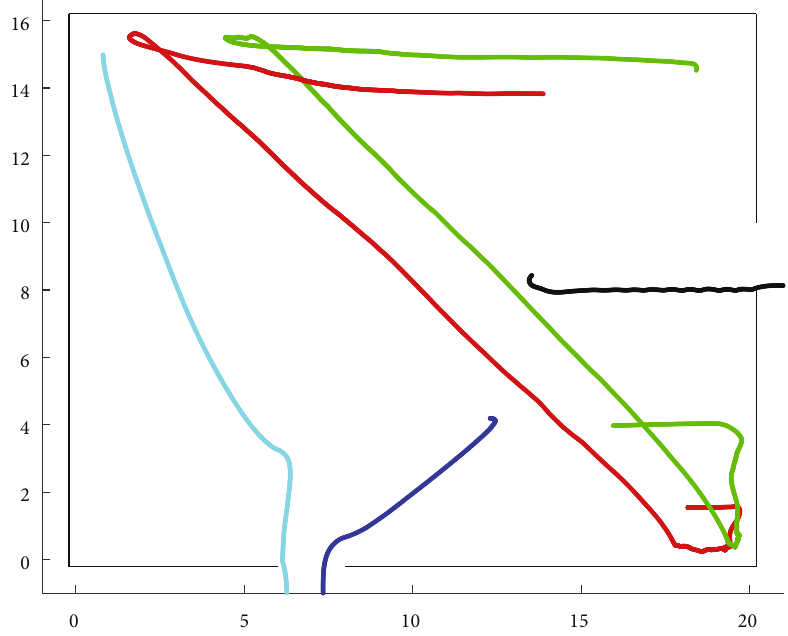
Figure 11: Traces of fi ve chosen pedestrians out of 200 pedestrians in case of 5% guiders in simulation. Black, blue, and cyan colors refer to footprints of guiders. Red and green colors are footprints of pedestrians that are not guiders. The entire time period of a simulation is set to 50